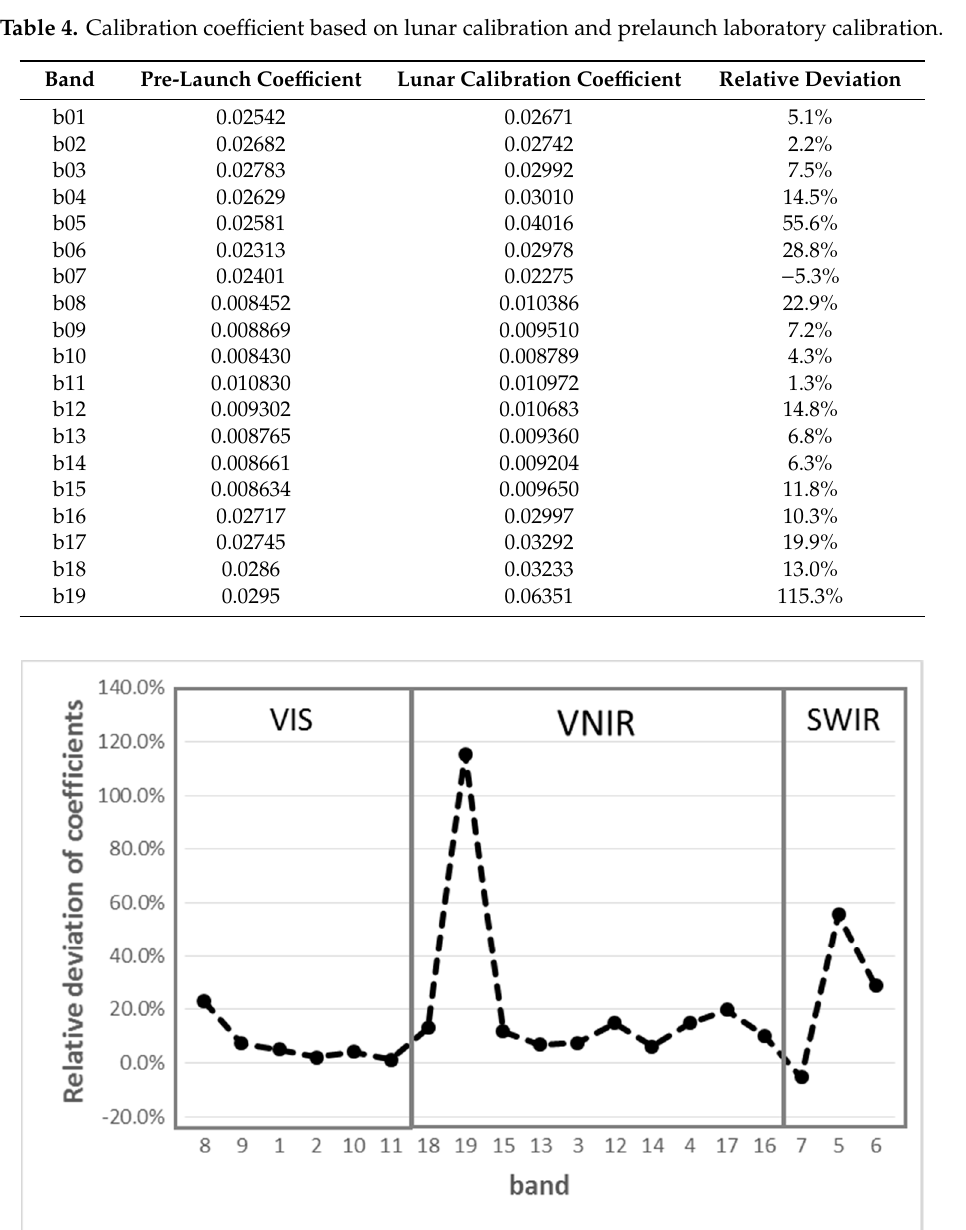
Figure 7. Relative differences of coefficients (classified based on FPA). X -axis is the MERSI band number, and Y -axis is the relative differences of coefficients, which ranges from -20% to 140%.